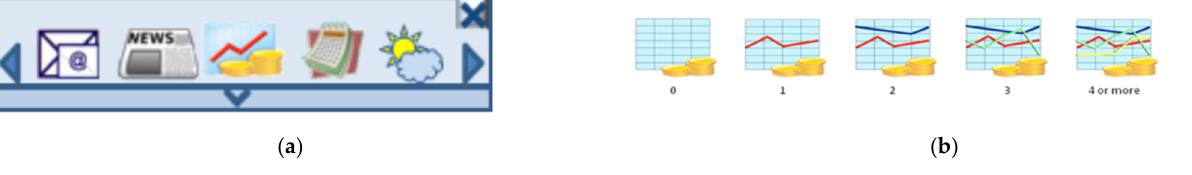
Figure 10. The new category bar : ( a ) Its organization, and ( b ) an example of status sensitive